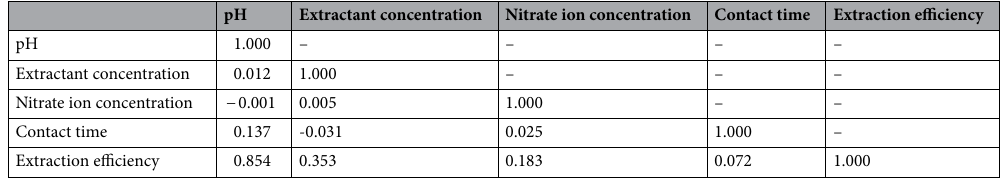
Table 1. Pearson’s correlation coefficients between operating parameters and extraction